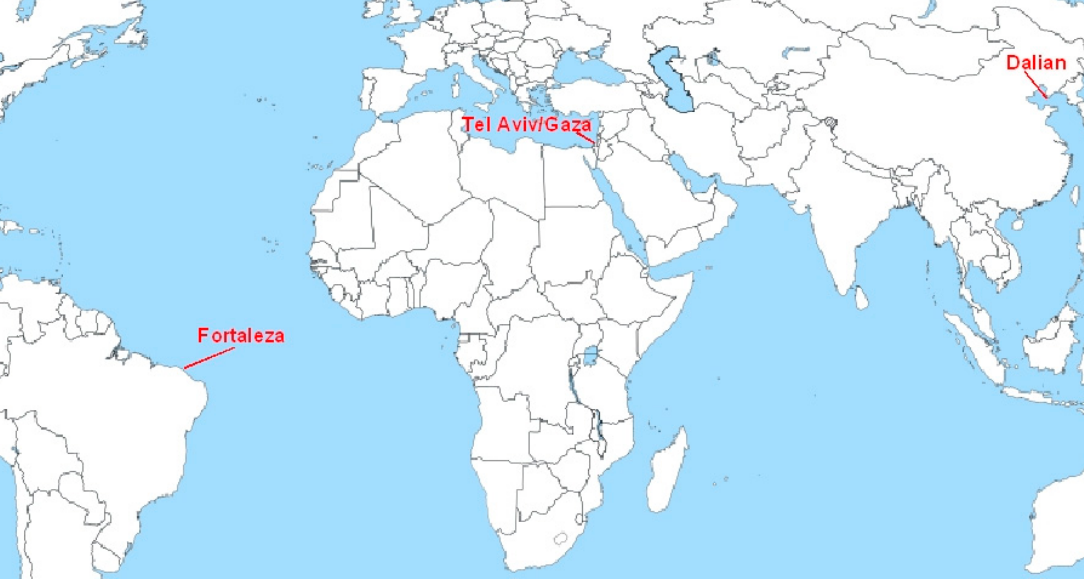
Figure 1. Location of the metropolises studied.